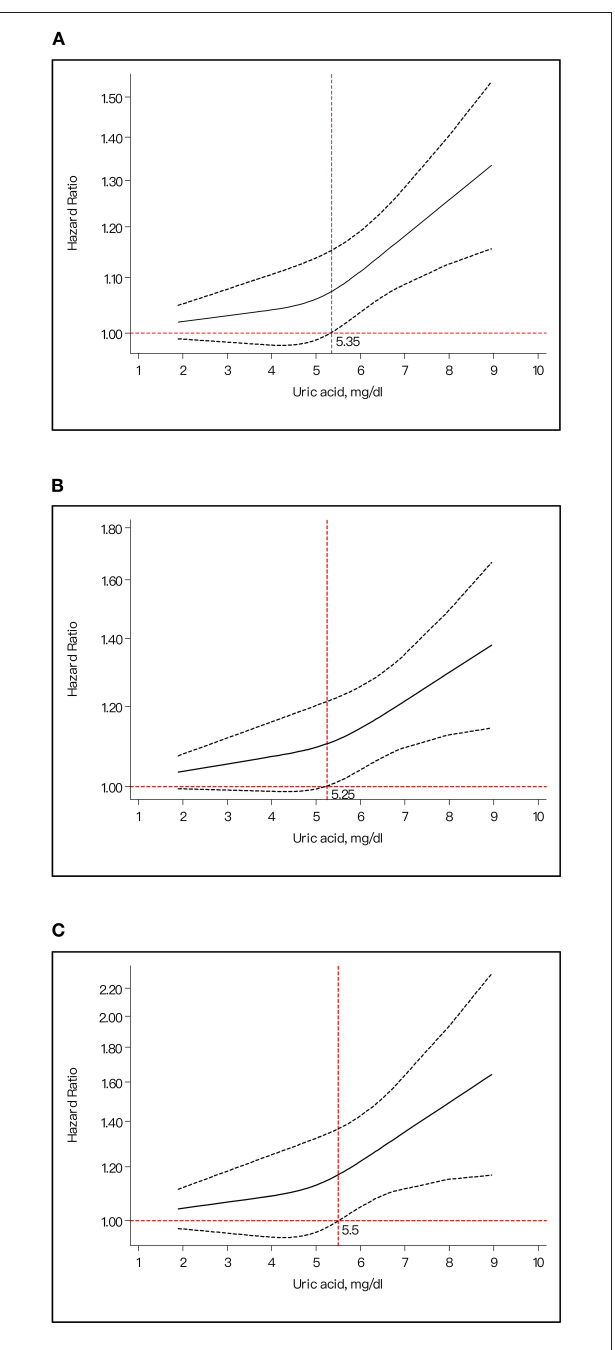
FIGURE 4 | The dose-response plot for the association of uric acid levels and risk of stroke. (A) Uric acid levels and risk of total stroke. (B) Uric acid levels and risk of ischemic stroke. (C) Uric acid levels and risk of hemorrhagic stroke.